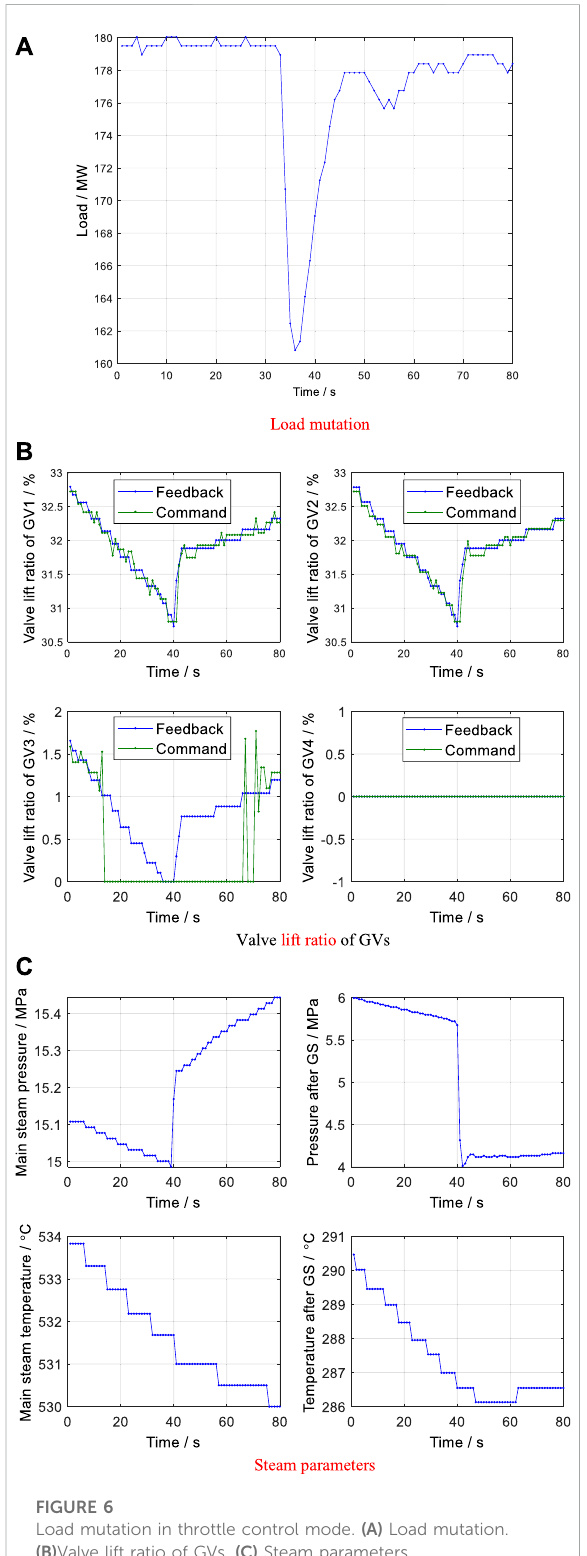
FIGURE 6 Load mutation in throttle control mode. (A) Load mutation. (B) Valve lift ratio of GVs. (C) Steam parameters.